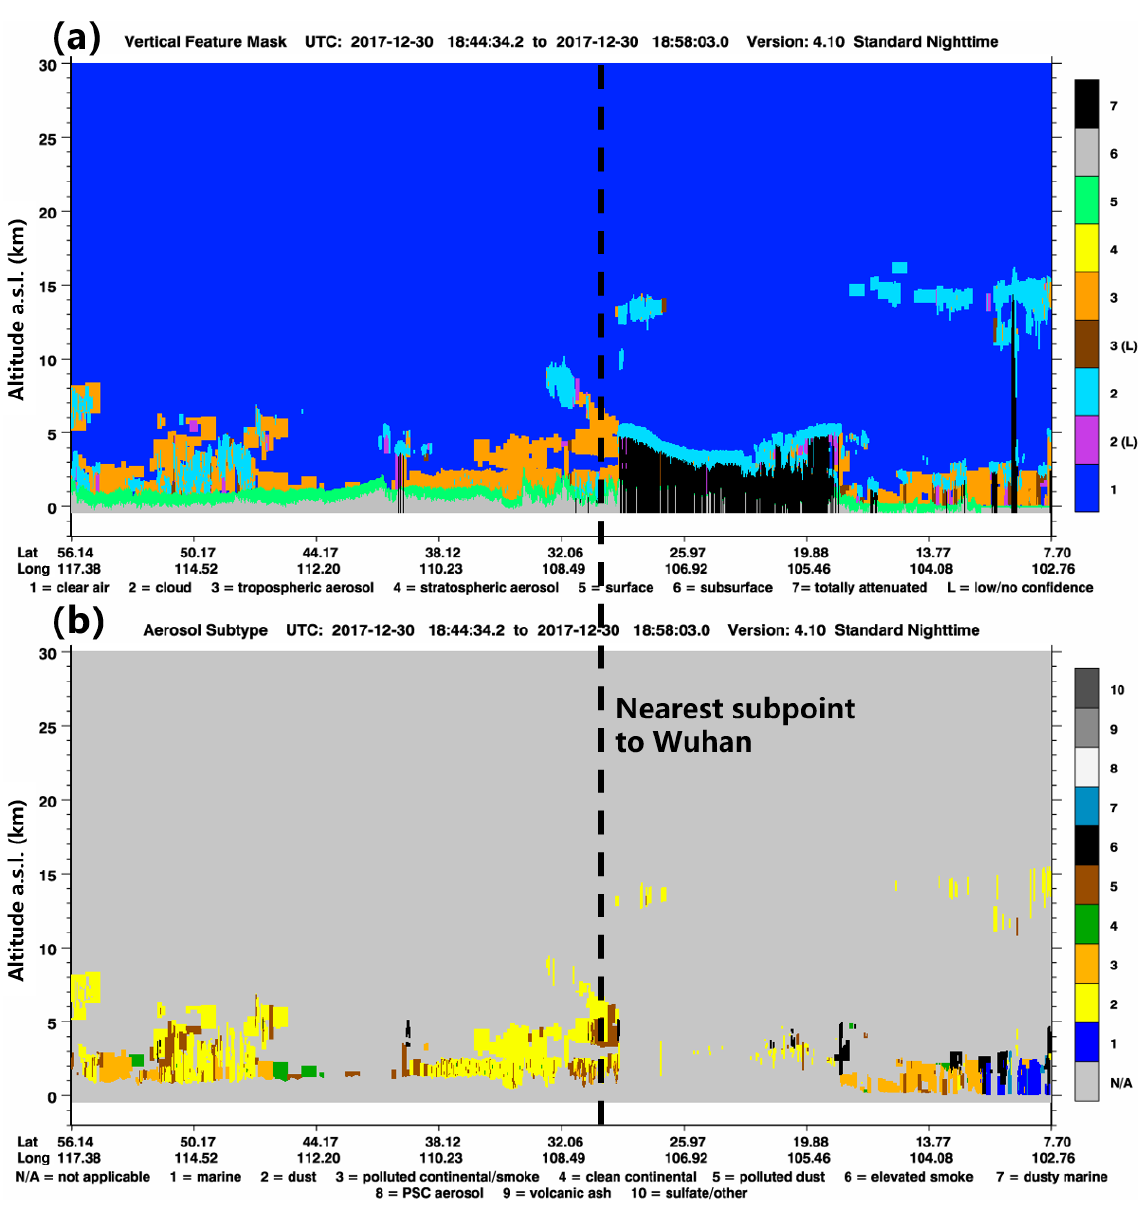
Figure 10. CALIPSO altitude–orbit cross section measurements of the CALIOP Level-2 (a) vertical feature mask and (b) aerosol subtype product from 18:44:34 to 18:58:03UTC on 30 December 2017. The corresponding orbit is 2017-12-30T18-31-05ZN. The vertical dashed line denotes the location of the nearest sub-point to